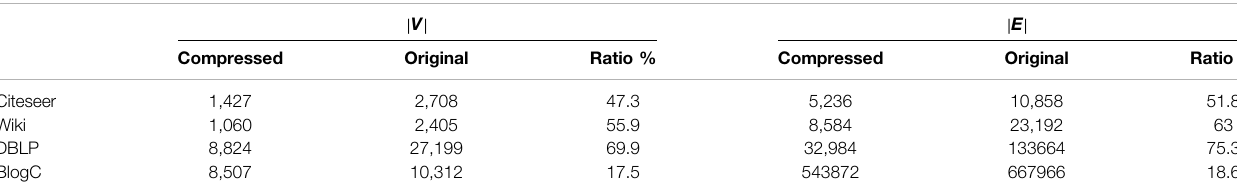
TABLE 2 | Compression ratio with the similarity threshold λ (cid:2) 0 . 5.